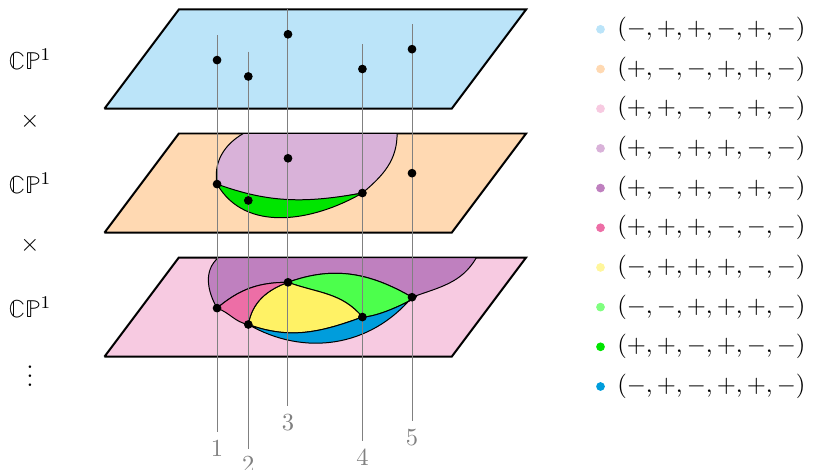
Figure 6 . Tiling of the celestial sphere for scattering with n = 6 holding { z 1 , z 2 , . . . , z 5 } fixed. The support of the various 3 → 3 channels are shown, along with the corresponding ~(cid:15)/ Z 2